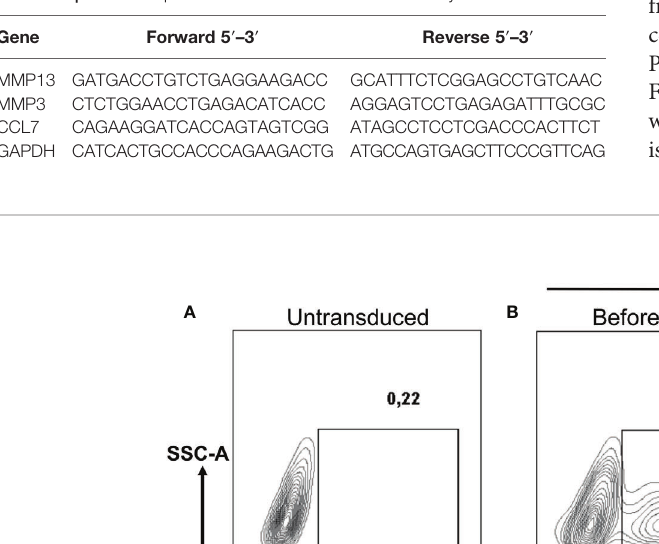
TABLE 1 | Primer sequences used in validation of PCR array.